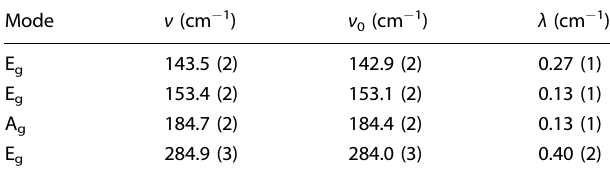
Table 1. The spin – phonon coupling constants in CrBr 3 at T = 19 K.